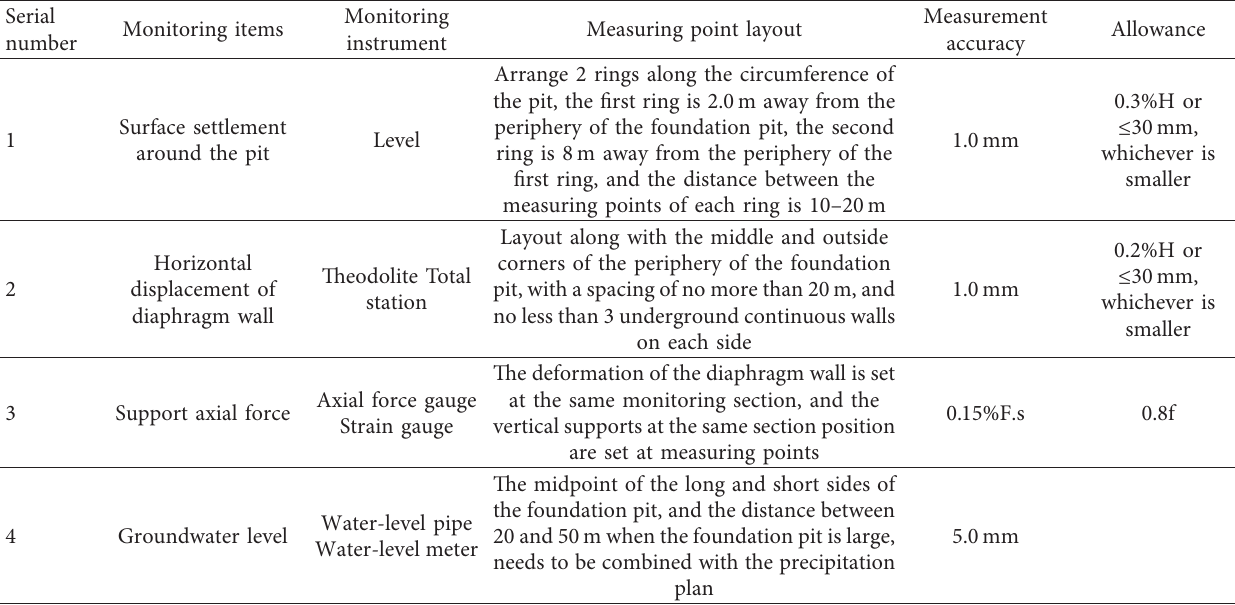
Figure 6: Plan of steel support (unit: m). Table 2: Main items of foundation pit